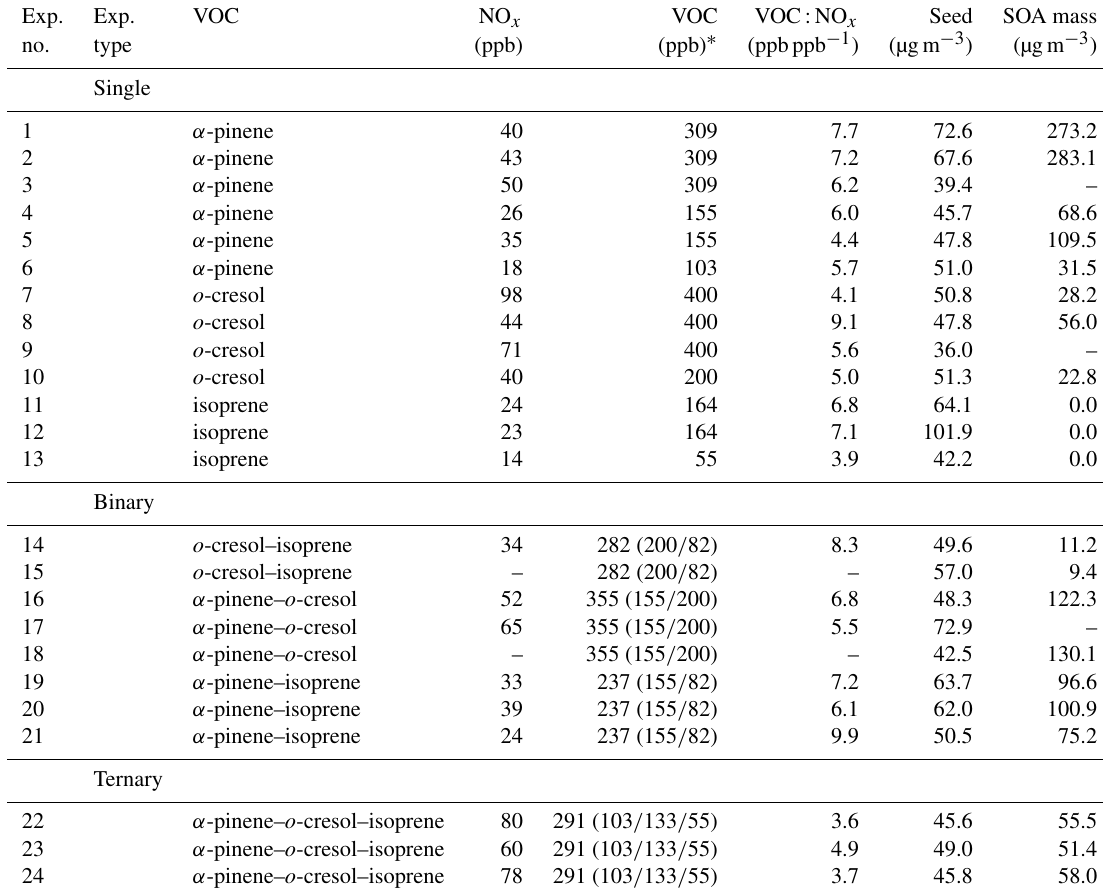
Table 1. List of initial conditions for all the experiments in the campaign.